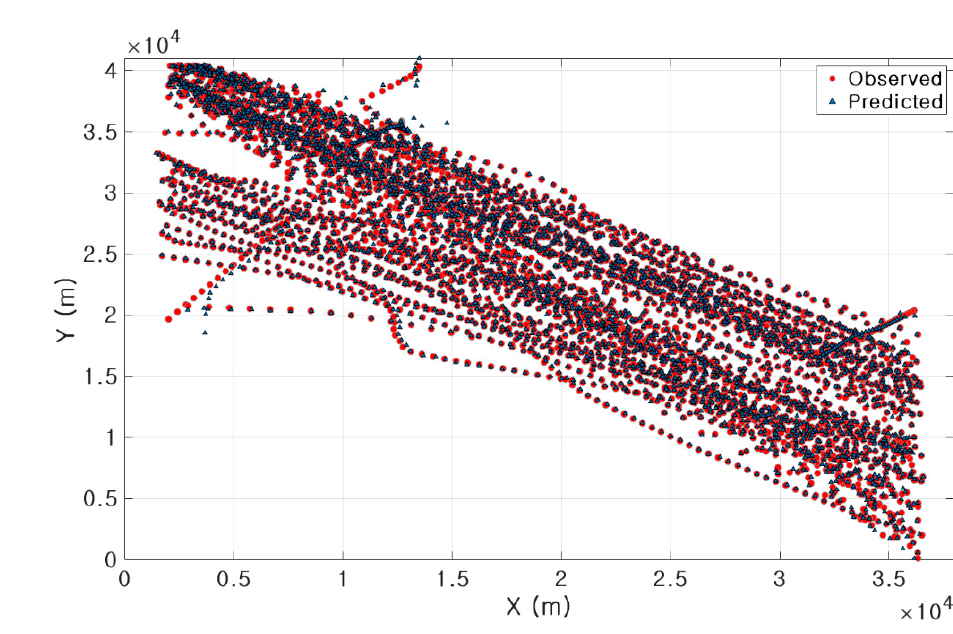
( i ) Predicted trajectory for group B using LSTM. Figure 8.